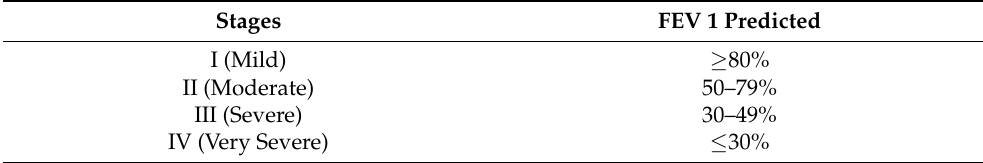
Table 1. Chronic obstructive pulmonary disease classification. Forced expiratory volume, FEV-1.